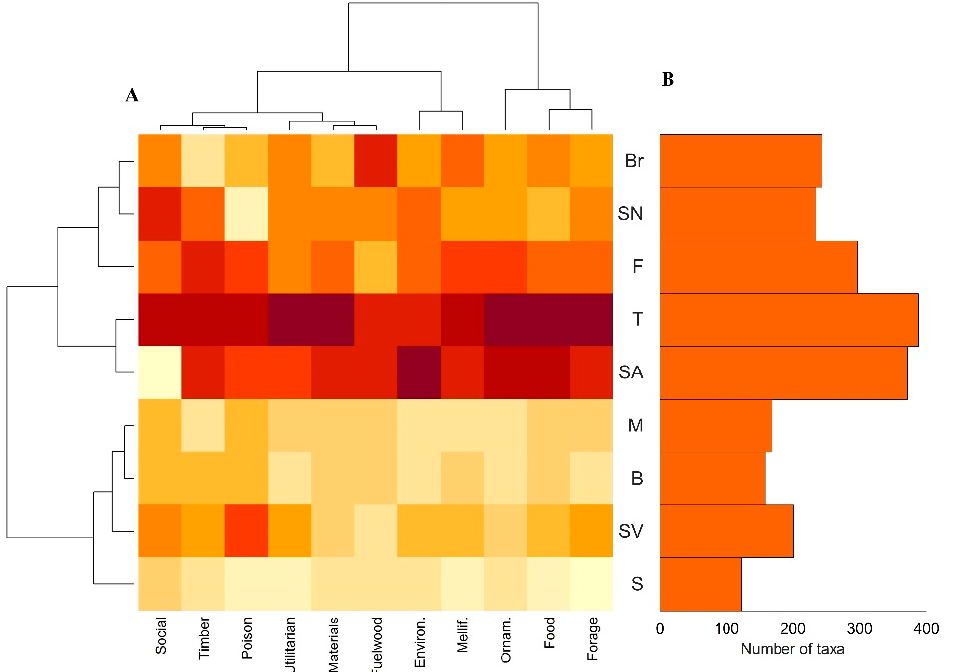
Figure 5. ( A ) Heatmap of the categories of uses identified for the species occurring in each island. Number of records of useful plants per category of use (axis x ) and islands ( y axis). Yellow boxes indicate the low values, and dark red boxes indicate high values. The heatmap was constructed based on a correlation matrix; the horizontal lines are the clusters of Cabo Verde islands (B—Boavista; Br—Brava; F—Fogo; M—Maio; S—Sal; T—Santiago; SA—Santo Ant ã o; SN—S ã o Nicolau; SV—S ã o Vicente) and the vertical columns are the clusters of the use categories. ( B ) Number of useful taxa per island.